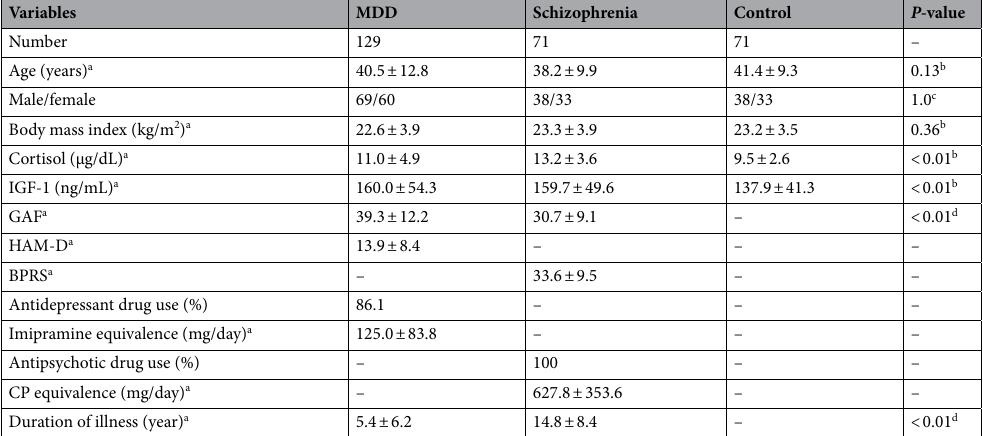
Table 1. Comparative profile of the major depressive disorder, schizophrenia, and control groups. a Data are expressed as means ± standard deviations. b Analysis of variance with Welch’s correction. c Chi-squared test. d Unpaired t test. MDD major depressive disorder, IGF-1 insulin-like growth factor 1, GAF Global Assessment of Functioning, HAM-D Hamilton Rating Scale for Depression, BPRS Brief Psychiatric Rating Scale, CP